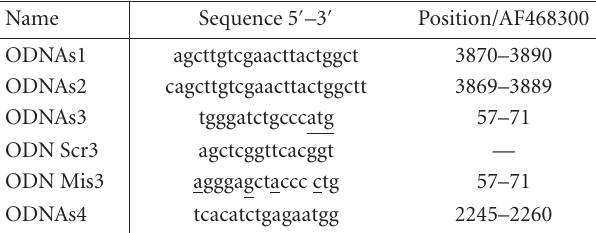
Table 2: List of antisens oligonucleotides directed against 6A3-5 . Se- quence and position (on human homologous held/Osa2) of di ff er- ent ODN directed against 6A3-5. Only ODNAS3 showed signifi- cant e ff ects on 6A3-5 expression. Scrambled ODN3 (ODN Scr3) and mismatched (ODN Mis3) as used to test sequence specificity of